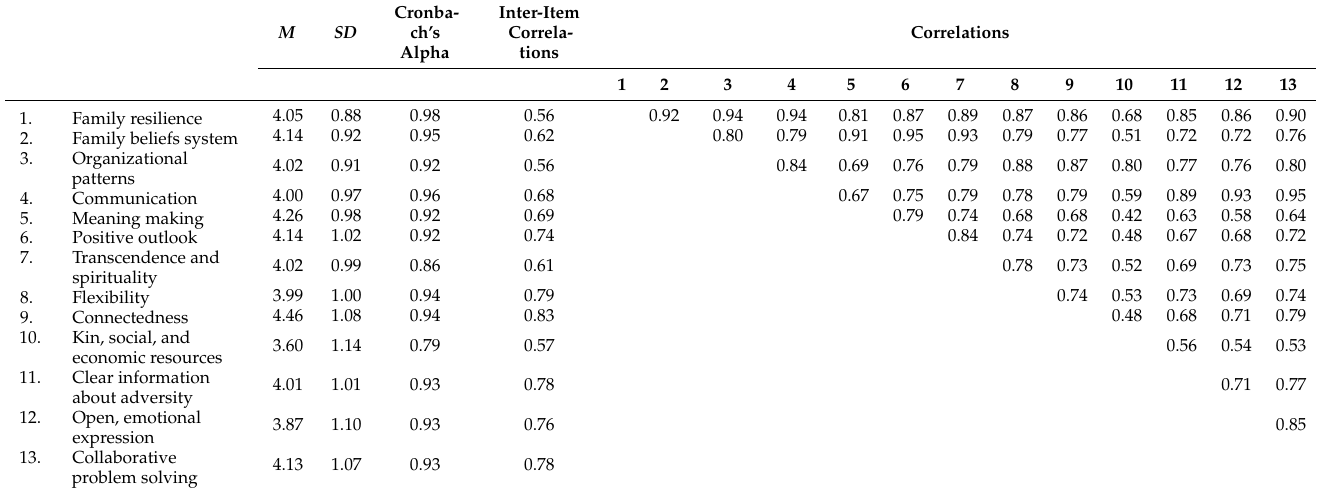
Table 6. Correlations of Chinese Family Resilience and its Subscales